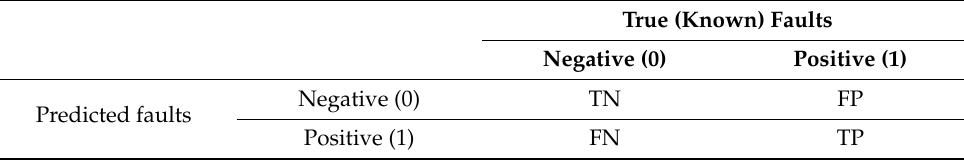
Table 3. Confusion matrix for fault